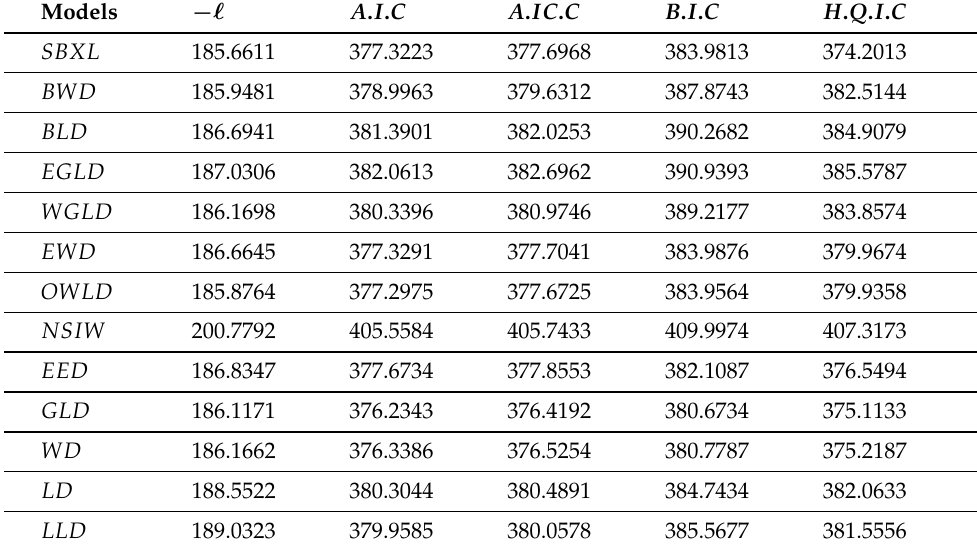
Table 13. Comparison of data set II fitting via information